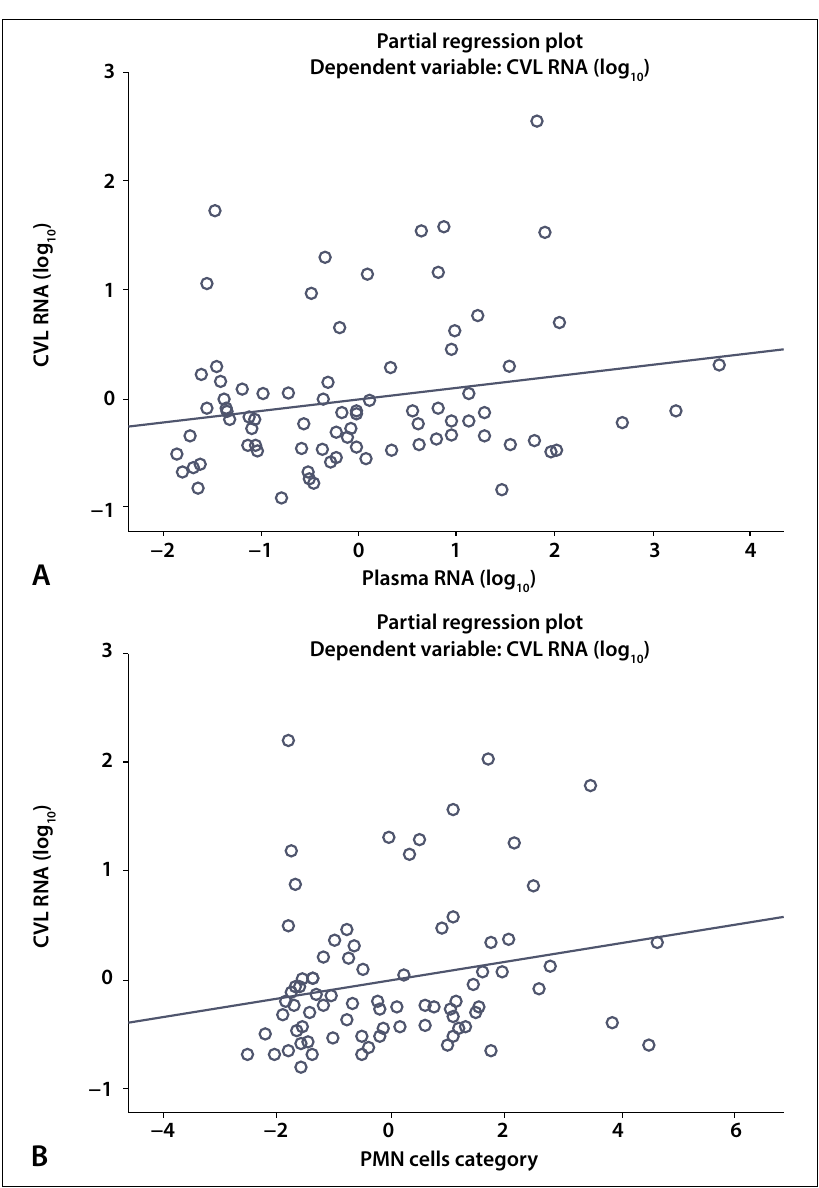
Fig. 2. Distribution of vaginal HIV RNA detectability by PMN cell groups ( p =0.005). (PMN=polymorphonuclear neutrophil; HMFs = high microscopic fields.)